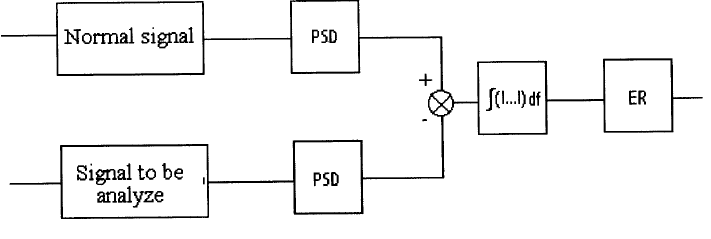
Fig. 9. Scheme of the ER parameter determination.